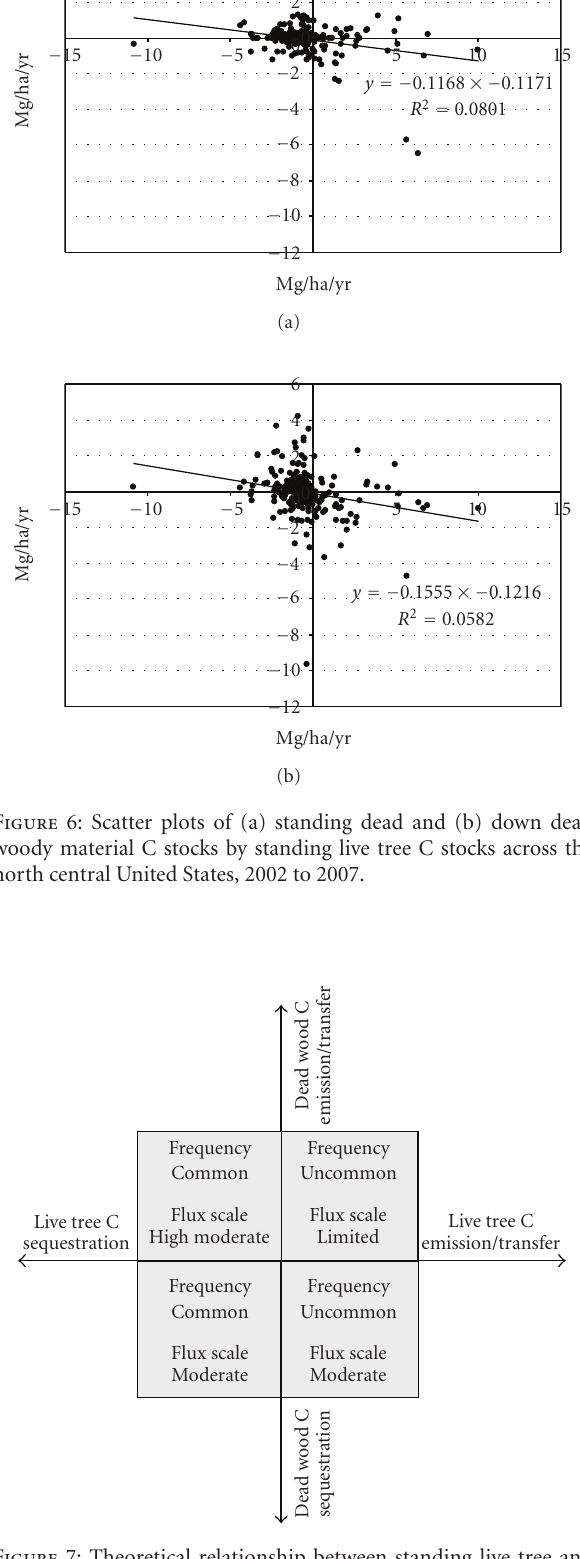
Figure 7: Theoretical relationship between standing live tree and dead tree C flux scales and